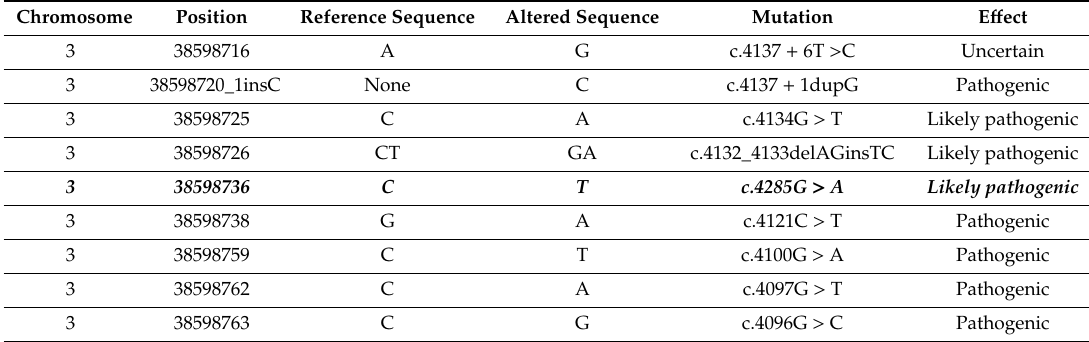
Table 1. Demonstration of mutational hot-spot in the region harboring the novel c.4285G > A SCN5A